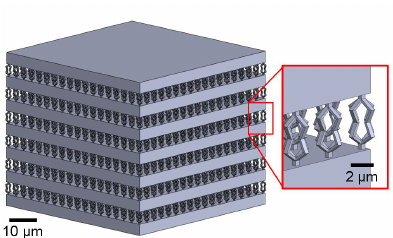
Figure 1. Computer-aided model of the designed one-dimensional photonic crystal investigated here. The photonic crystal consists of alternating high-density compact and low-density layers. The nominal thickness of the high-density layers is 3.35 µm. The low-density layers with a nominal thickness of 3.40 µm are composed of an array of bow tie flexures which are arranged in a square- lattice pattern on the surface with a lattice constant of 2.85 µm. The corresponding nominal volumetric fill factor f i of the low-density layer is f i =